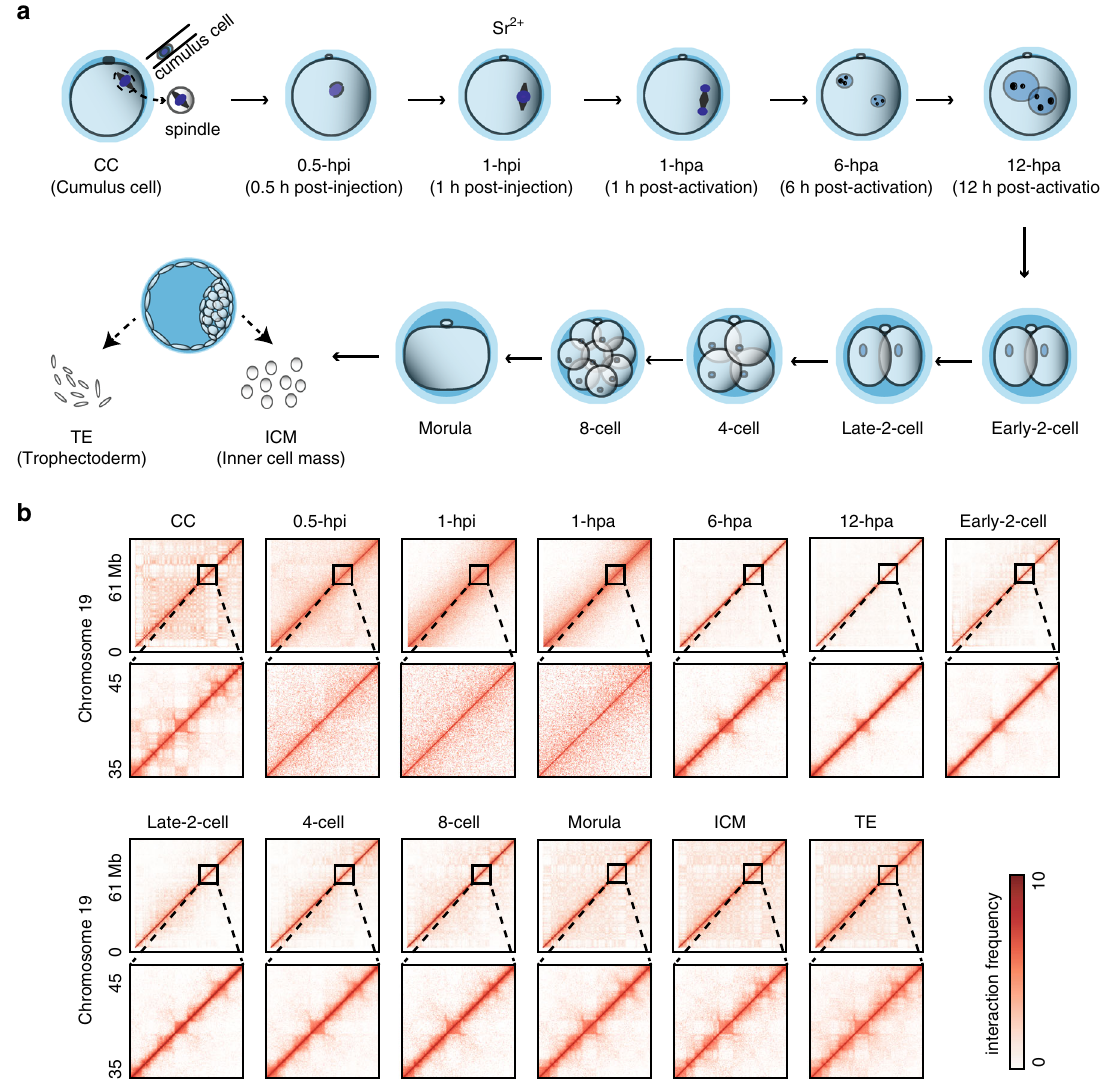
Fig. 1 Landscape of chromatin organization in early SCNT embryo development. a Illustration of SCNT procedure and sample collections. According to the classical procedure of mouse cloning, donor nuclei from cumulus cells were injected into enucleated oocytes. Reconstructed embryos were chemically activated 1 h post-injection by culture in the Ca 2 + -free CZB medium including strontium chloride. b Hi-C produces a genome-wide contact matrix. The normalized Hi-C interaction frequencies (100-kb bin, chromosome 19) in each sample. Zoomed-in views (40-kb bin) are also shown. Each pixel represents all interactions between a 100-kb (40-kb) locus and another 100-kb (40-kb) locus; intensity corresponds to the ICE normalized value (0 –